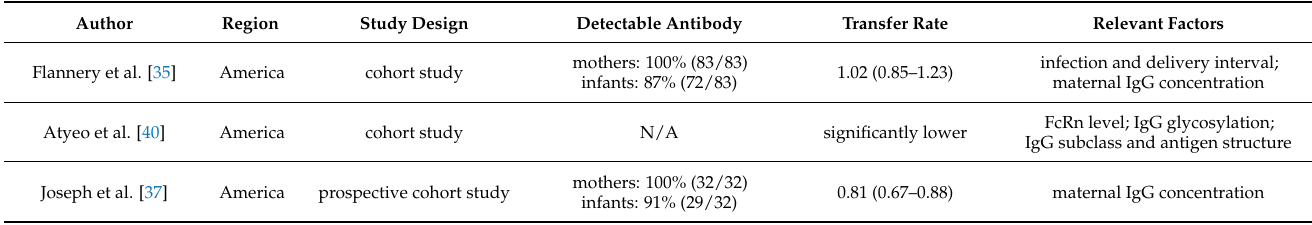
Table 1. Summary of several studies on maternal and fetal antibodies after infection with severe acute respiratory syndrome coronavirus 2